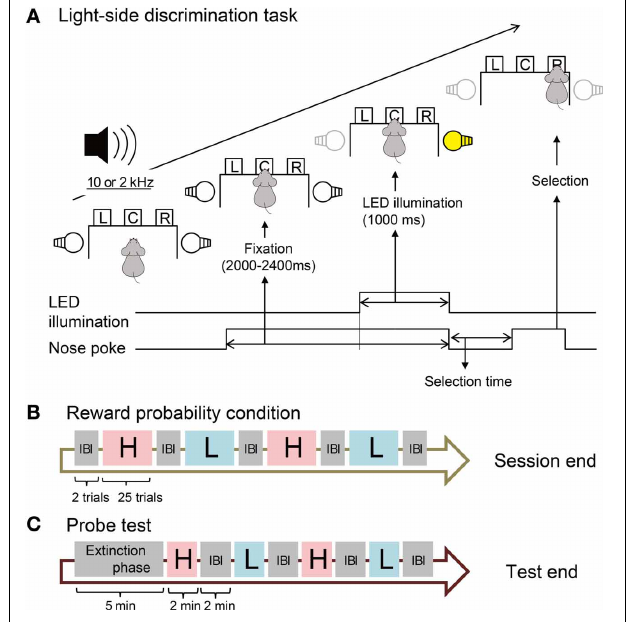
FIGURE 1 | Design of behavioral task. (A) Procedure of the light-side discrimination task. One of two pure tones (2 and 10kHz) is constantly presented during the trial. The operant chamber is equipped with left (L), center (C), and right (R) sensor holes for nose-poke behavior. The bottom lines and arrows show the time course of events in one trial. (B) Sequence of blocks with different reward probability conditions. In each block of 25 trials, the reward probability is fixed to high (H, 80%) or low (L, 20%). The rats are informed of the high or low probability of the reward by one of the two pure tones. No tone is presented in inter-block intervals (IBI). (C) Sequence of blocks in the probe test. One of the two pure tones is presented in each block but rats obtain no reward. No tone is presented during the extinction